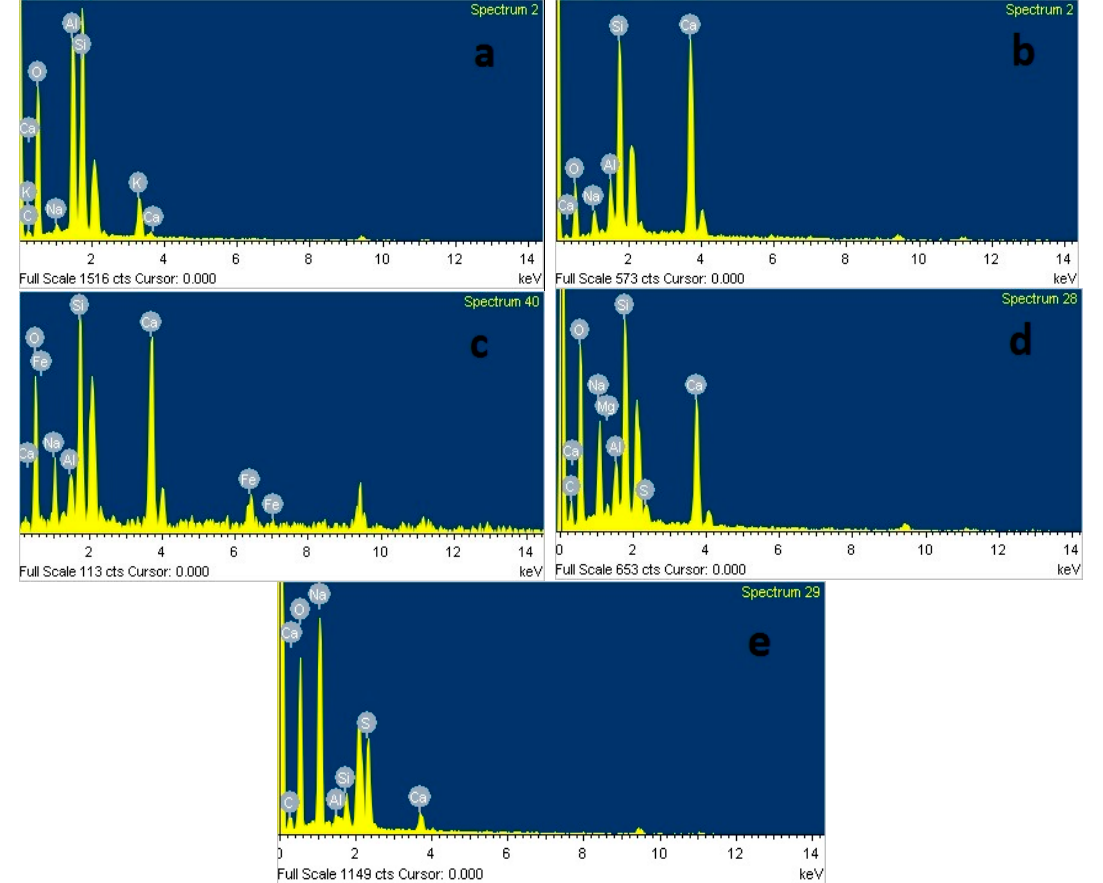
Figure 12. Energy dispersive X-ray spectroscopy (EDS) image of spots in Figure 11: ( a ) Spot labeled 1; ( b ) Spot labeled 2; ( c ) Spot labeled 3; ( d ) Spot labeled 4; and, ( e ) Spot labeled 5.